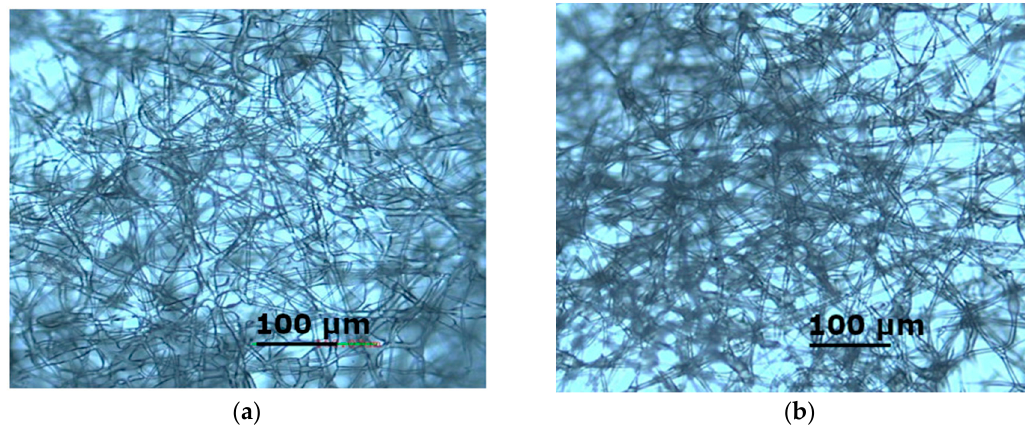
Figure 1. Microphotos of nonwoven fiber: ( a ) 100% PLA and ( b ) 95% PLA/5% NR. Magnification of 100 times.